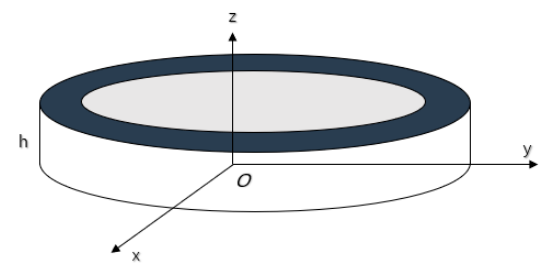
Figure 8. Schematic diagram of PZT with metal ring.